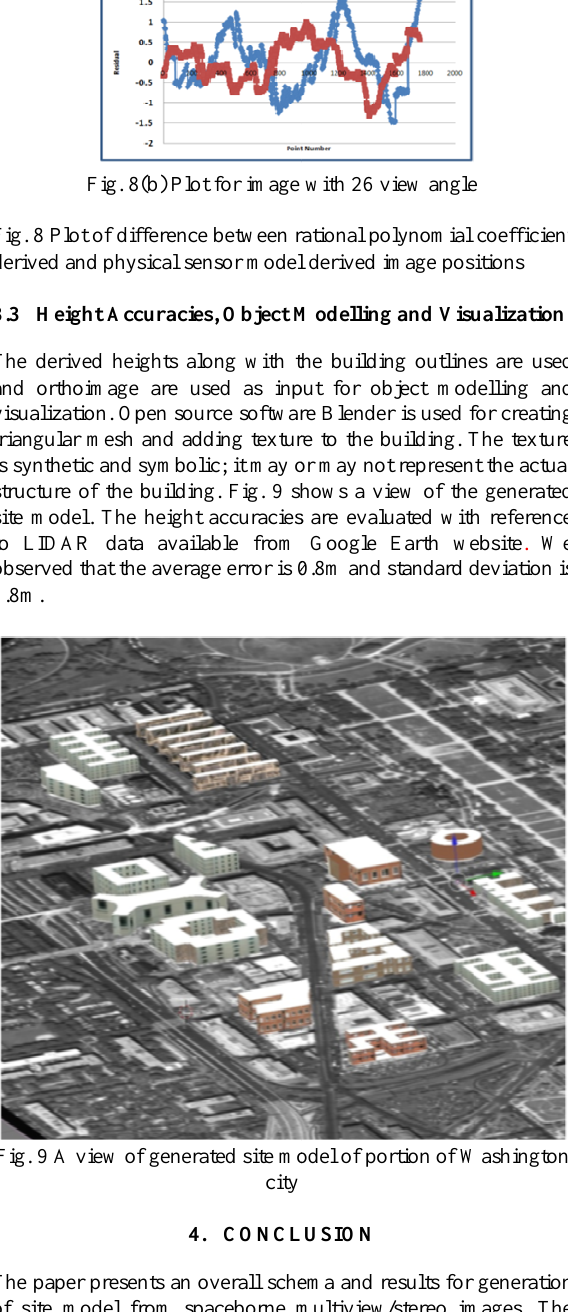
Table 1 Results of Relative orientation of Multi